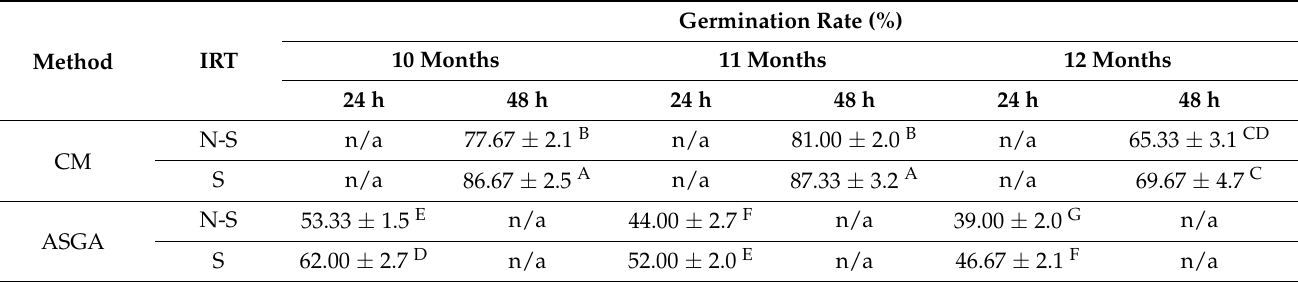
Table 2. Comparison of the germination rates for the conventional method (CM) and an automatic soaking and germination accelerator unit (ASGA) with no stimulation and stimulation via infrared radiation treatment (IRT) at each storage period.